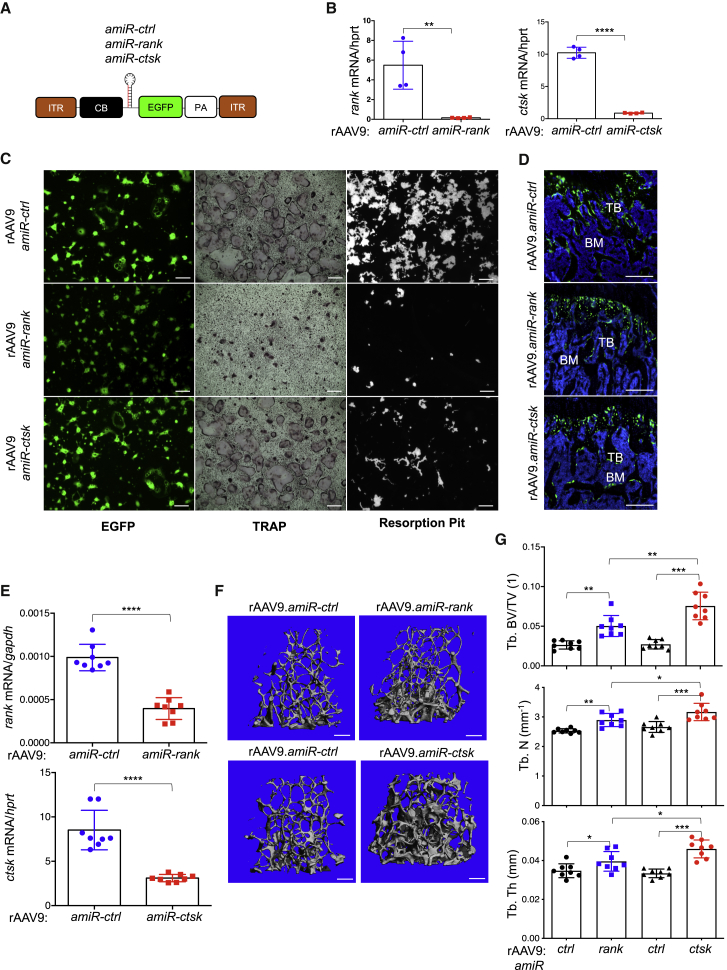
rAAV9-Mediated Gene Silencing in OCs Increases Bone Mass in Mice(A) Diagram of the rAAV9 constructs containing a CMV (cytomegalovirus) enhancer/chicken β-actin promoter (CB), amiR-ctrl, amiR-rank, or amiR-ctsk, an EGFP reporter gene, β-globin poly(A) sequence (PA), and inverted terminal repeats (ITRs). (B and C) Two days after treatment with M-CSF and RANKL, wild-type pre-OCs were transduced with either rAAV9 carrying amiR-ctrl, amiR-rank, or amiR-ctsk (1011 GC) and then differentiated into mature OCs. (B) Levels of rank or ctsk mRNA were measured by RT-PCR and normalized to hprt. (C) Transduction efficiency, OC differentiation, and resorption activity were assessed by EGFP expression, TRAP staining, and resorption pit assay, respectively. Representative images of TRAP-stained OCs and resorption pit are displayed (n = 4/group). Scale bars, 1 mm. (D–G) A single dose of 8 × 1011 GC of rAAV9 carrying amiR-ctrl, amiR-rank, or amiR-ctsk was i.v. injected into 2-month-old female mice. Two months later, EGFP expression in the cryosectioned femur and mRNA levels of rank or ctsk in the tibia were assessed by fluorescence microscopy (D) and RT-PCR (E), respectively (n = 8/group). Femoral trabecular bone mass was assessed by microCT. Representative 3D-reconstruction (F) and relative quantification (G) are displayed (n = 8/group). Scale bars, 200 μm. Values represent mean ± SD. *p < 0.05, **p < 0.01, ****p < 0.0001 by an unpaired two-tailed Student’s t test and one-way ANOVA test.